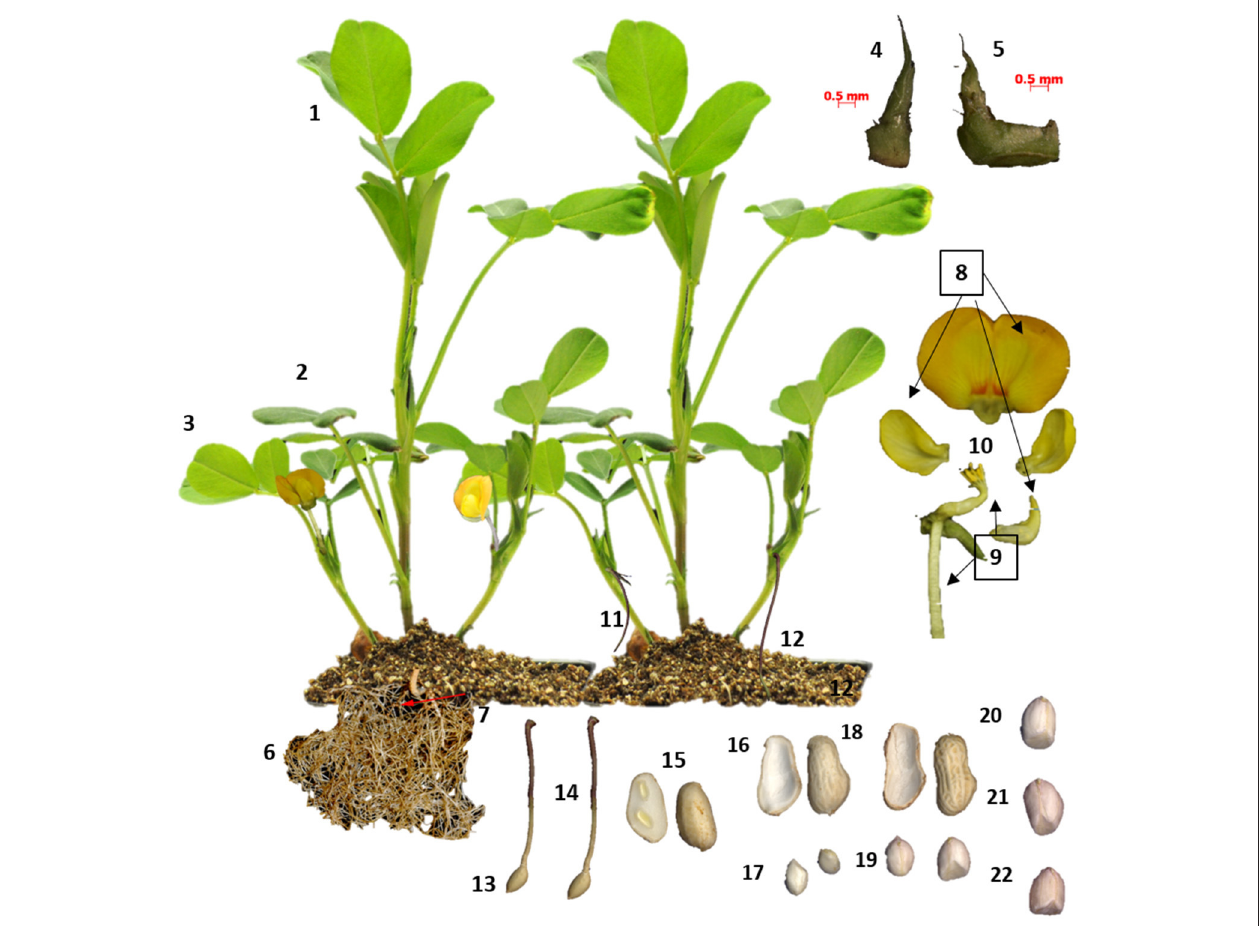
FIGURE 1 | Tissues sampled from cv Tifrunner. (1) seedling leaf 10d post emergence (2) main stem leaf (3) lateral (n + 1) leaf (4) vegetative shoot tip from main stem (5) reproductive shoot tip from first lateral (n + 1) (6) 10d roots (7) 25d nodules (8) perianth (9) gynoecium (10) androecium (11) aerial gynophore tip (12) subterranean gynophore tip (24 h) (13) Pattee 1 pod (14) Pattee 1 stalk (15) Pattee 3 pod (16) Pattee 5 pericarp (17) Pattee 5 seed (18) Pattee 6 pericarp (19) Pattee 6 seed (20) Pattee 7 seed (21) Pattee 8 seed (22) Pattee 10